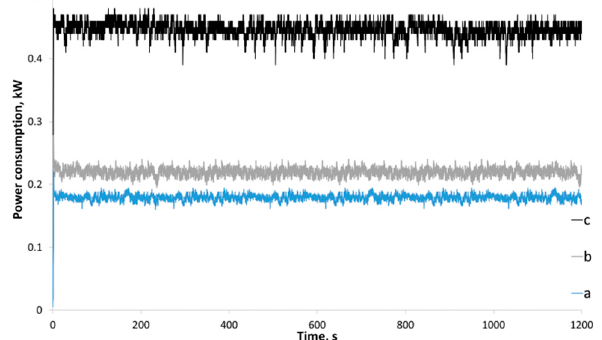
Figure 7. Current power consumption of the planetary ball mill: (a) the planetary gear without jars; (b) the planetary gear with empty jars; (c) jars containing grinding bodies and medium MW chi- tosan.